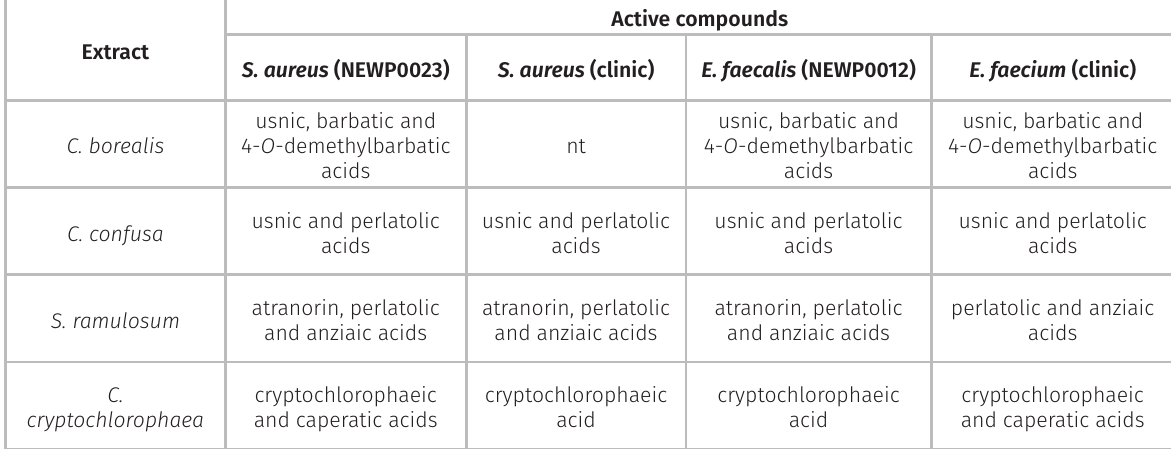
Table III. Active components in bioautography assay of selected extracts.